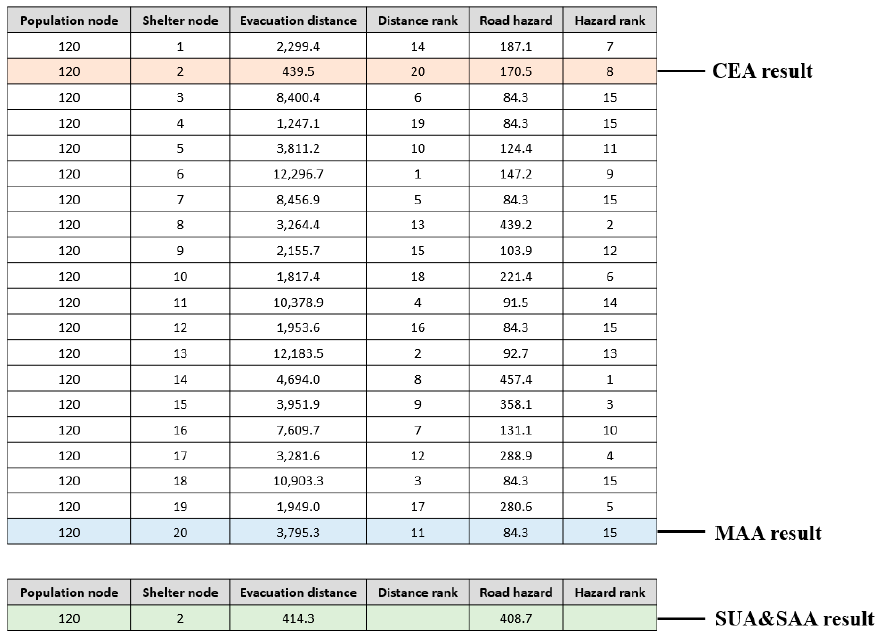
Figure 5. Example of evacuation route results. The first table shows routes filtered by the routing phase of comprehensive evacuation route analysis (CEA). Minimum-hazard, assigned-shelter analysis (MAA) selects a route minimizing road hazards (the first two shortest paths are not selected due to fully occupied shelters). CEA selects a route with a lower evacuation distance than the MAA route. Although this route is longer than the shortest-path, unassigned-shelter analysis (SUA) / SAA routes, it results in significantly less hazard